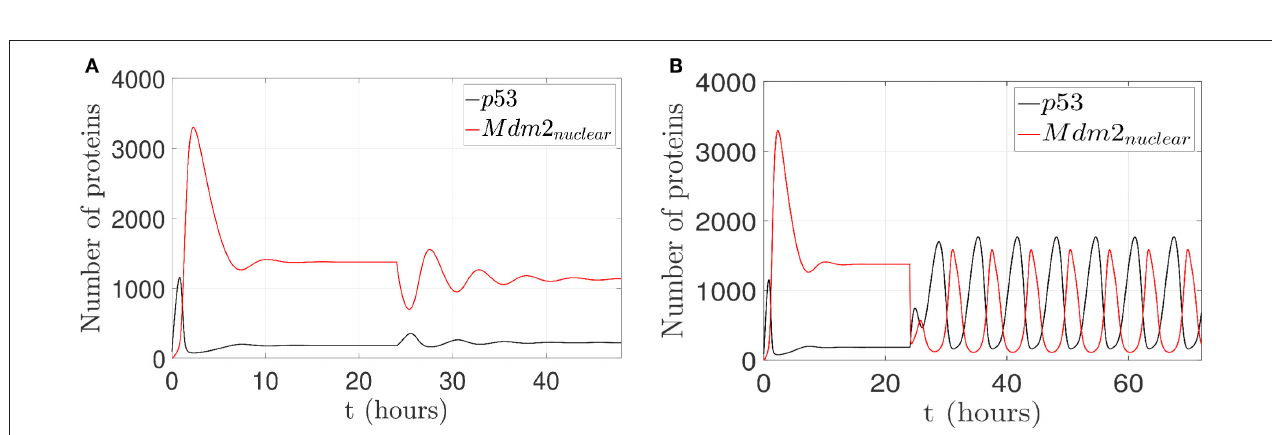
FIGURE 6 | Proposed scenario simulations to achieve restoration of an oscillatory pattern under gamma-radiation in the p53-Mdm2 network regulated by p14ARF. For both tests is possible to observe overexpressed Mdm2-mediated p53 degradation as carcinogenic initial behavior at first 24 h. In (A) , control action with ( k a u 1 ) in a range between 0 and 1.5 proteins / s , the oscillatory pattern under gamma-radiation is not achieved (24–48 h) and likewise in (B) oscillatory pattern under gamma-radiation under pinning control (24–72 h) with ( k a u 1 ) in a range between 1.6 and 9.5 proteins / s is achieved.